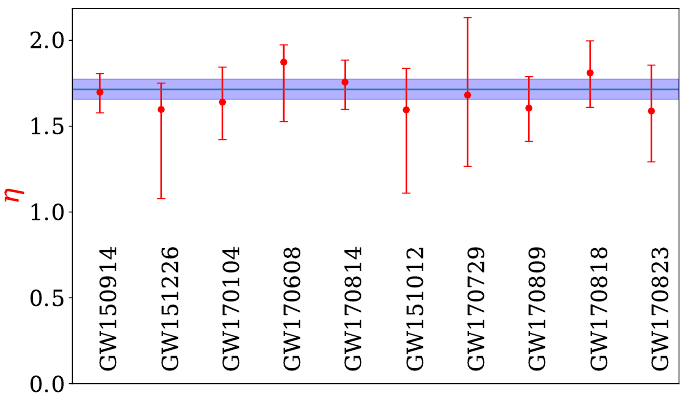
Figure 28. Determination of η for the events in O1 and O2 [22]. FIG. 5. Determination of η using (1). Table 10. Echoes best fit time delays and corresponding N E using method II for O1 and O2 events